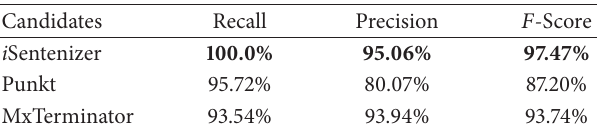
Table 12: Trained on the Tycho Brahe corpus and tested on the Brown corpus.